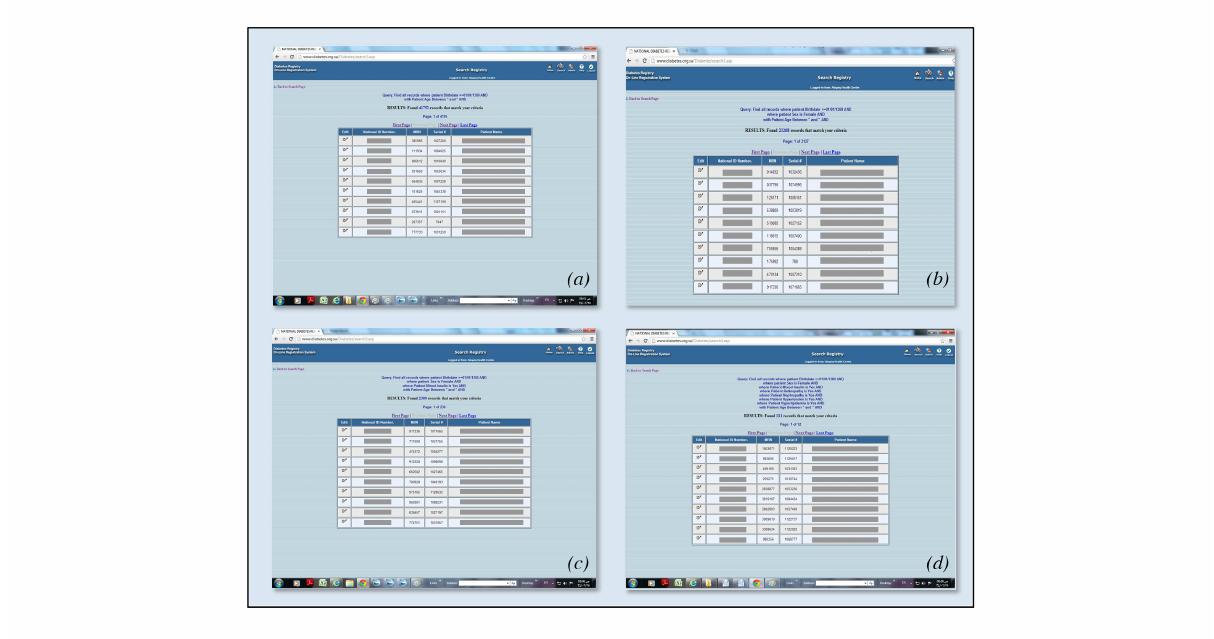
Figure 6. Lists of patient names, national IDs, and hospital and serial numbers generated by the search tool of the SNDR at different stages: (a) all patients between ages 45-65 years, (b) who are female, (c) using premixed insulin, (d) with proliferative retinopathy, microalbuminuria, hypertension, and hyperlipidemia.